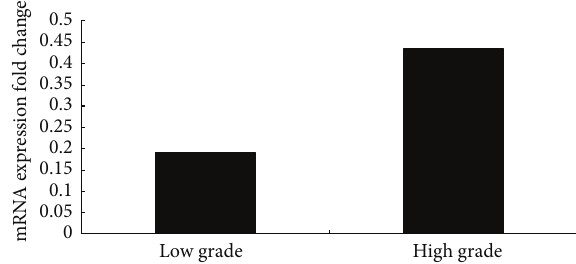
Figure 1: RT-PCR analysis showed that Girdin mRNA was upregu- lated in high-grade Gliomas cancer tissues when compared to low- grade tumor tissues ( 𝑃 = 0.001 ).